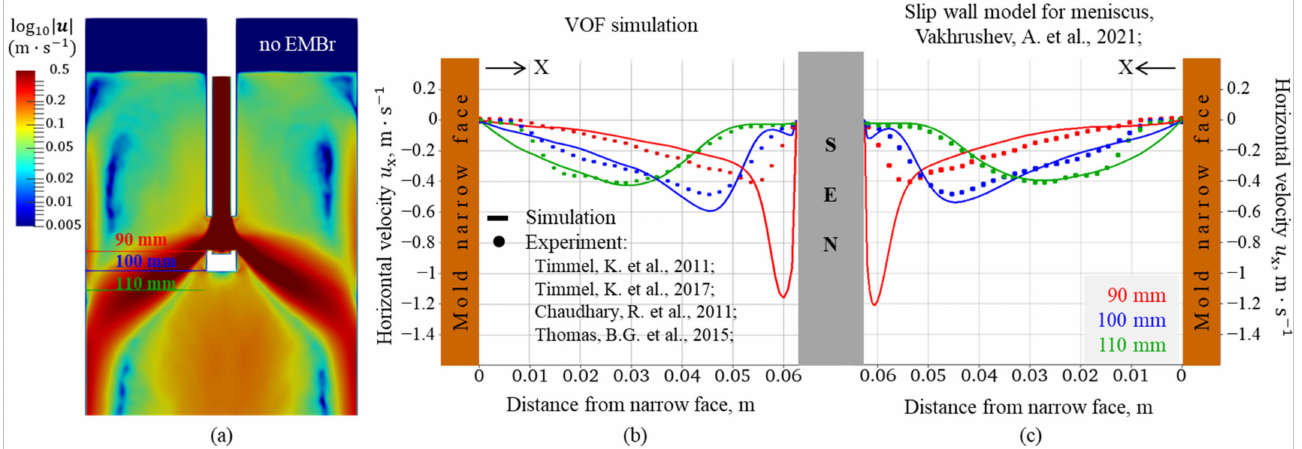
Figure 3. Verification of the simulation results without EMBr (Case 0A): ( a ) time-averaged melt velocity (midplane); horizontal velocity ( b ) in this study (experimental data from [20–23]) and ( c ) in the previous publication data from [26].